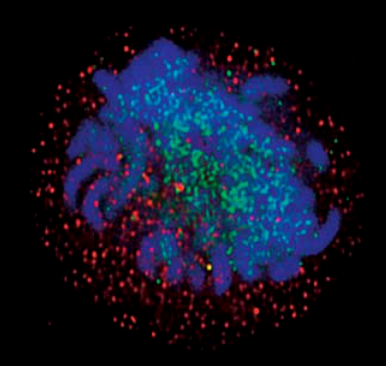
Figure 1. SIRT-1 Deacetylase—the Human Enzyme That Promotes Cell Survival—in a Dividing Human Cell The enzyme is marked in red, and the image is superimposed on acetylated proteins (green) and condensed chromosomes (blue). (Image courtesy of David